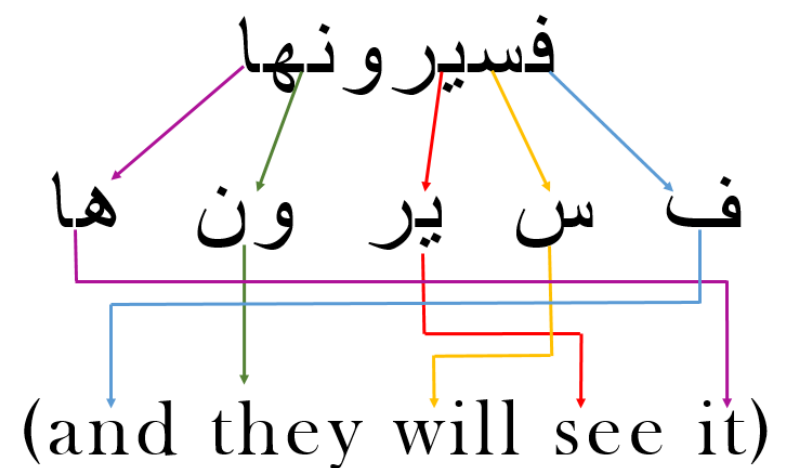
Figure 2. Example of the ambiguity of Arabic